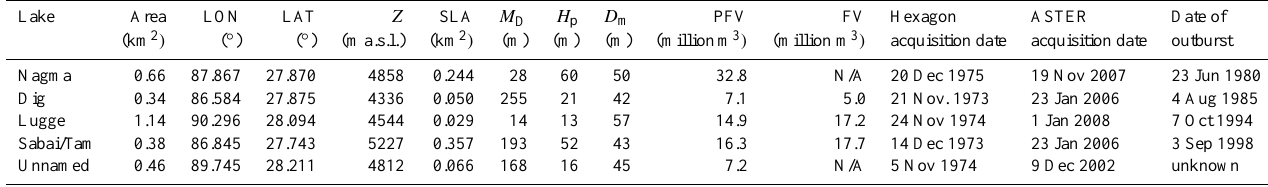
Table 1. Characteristics of the five GLOF lakes studied (Fig. 5). Lake